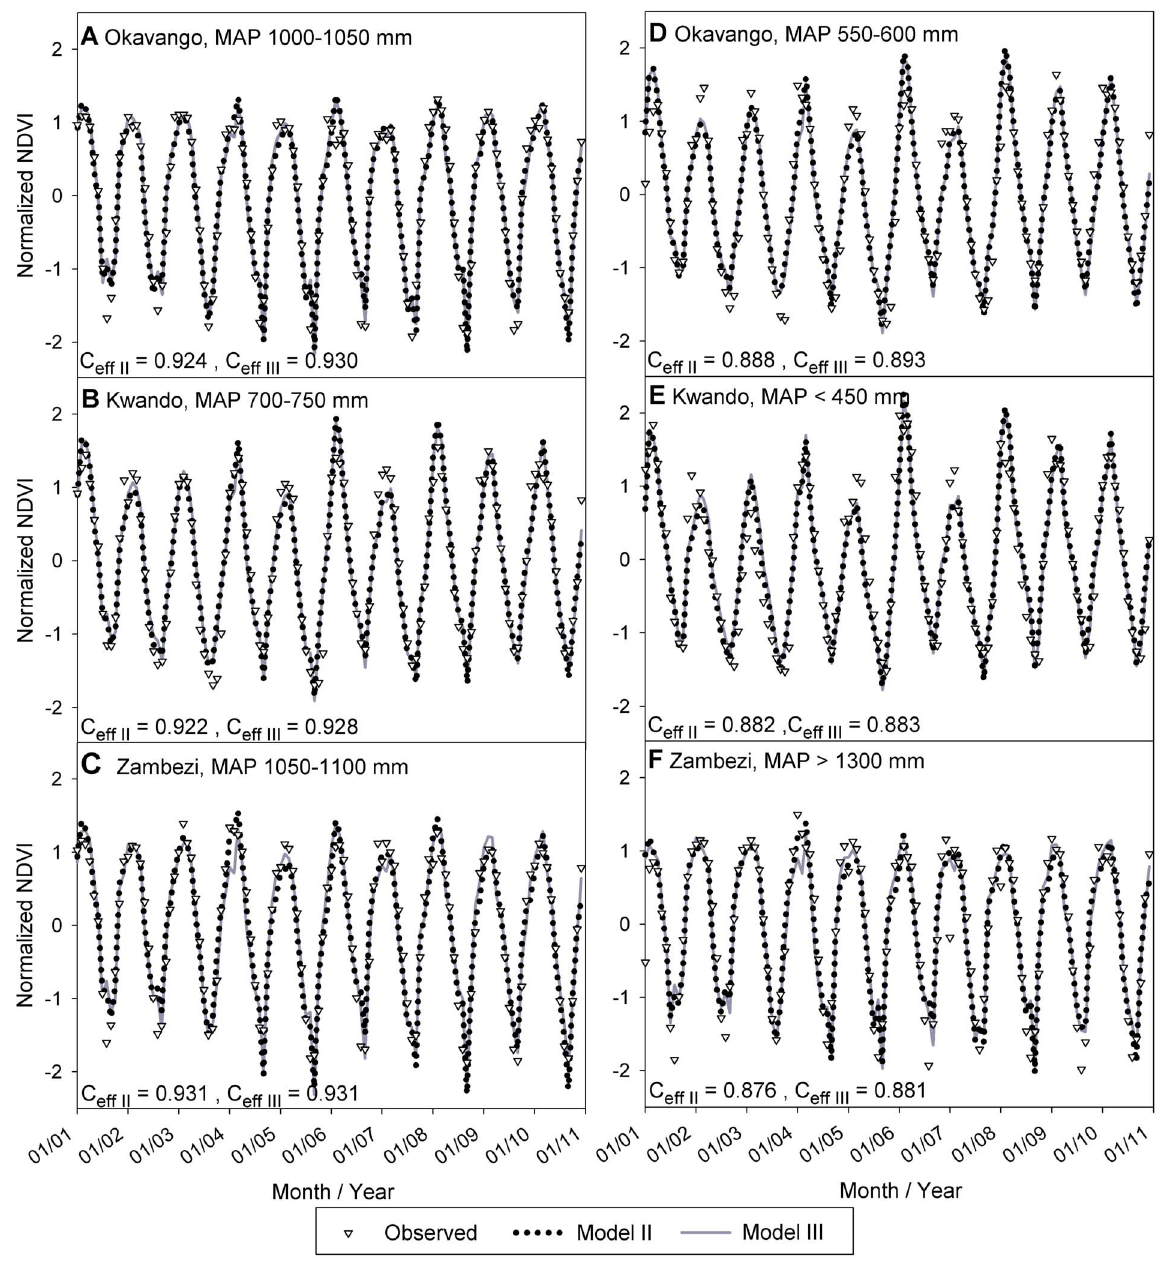
Figure 6. Comparison of model II and III results and measured NDVI. Best-performing ( A,B,C in left column) and worst-performing ( D,E,F in right column) polygons in each watershed are shown.